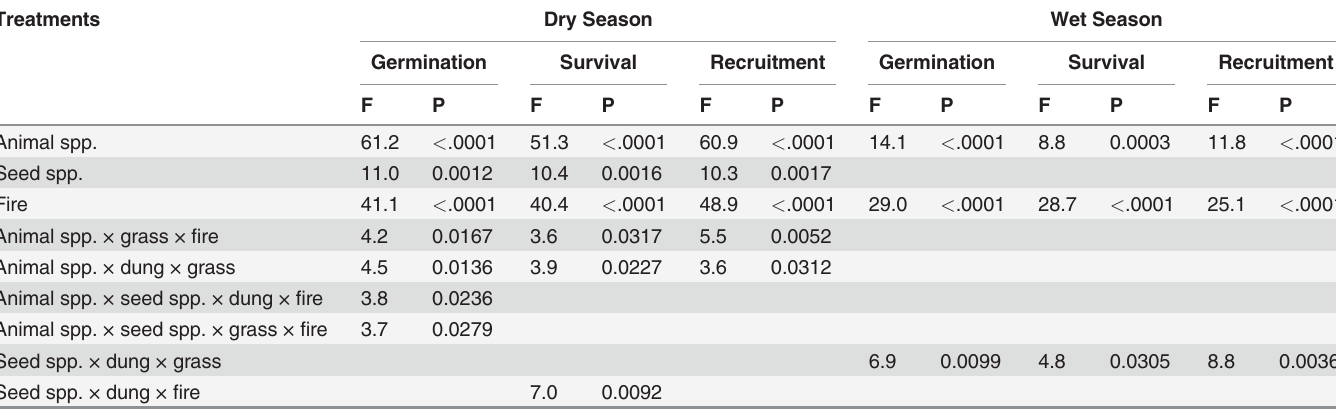
Table 2. F values and P values for the effects of the seven treatments and their interactions and their interactions on seedling emergence, seedling survival and seedling recruitment. Treatments